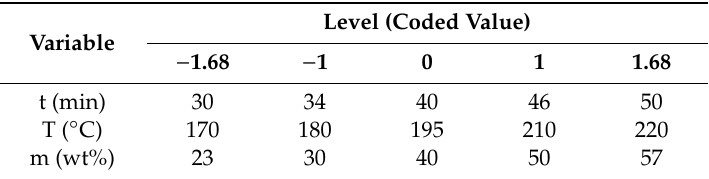
Table 1. Levels of investigated factors in this study.